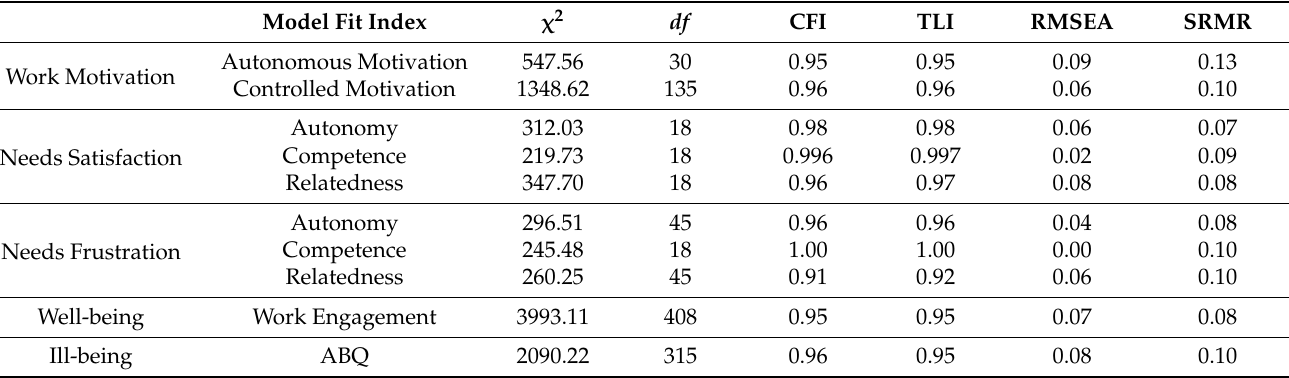
Table 3. Model Fit Index for Multi-group CFA Testing Metric Invariance for All the Measurements across the Three